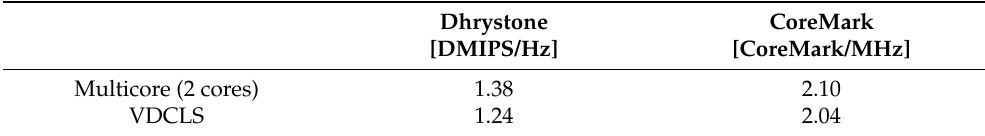
Table 1. Performance comparison between regular and VDCLS implementation.